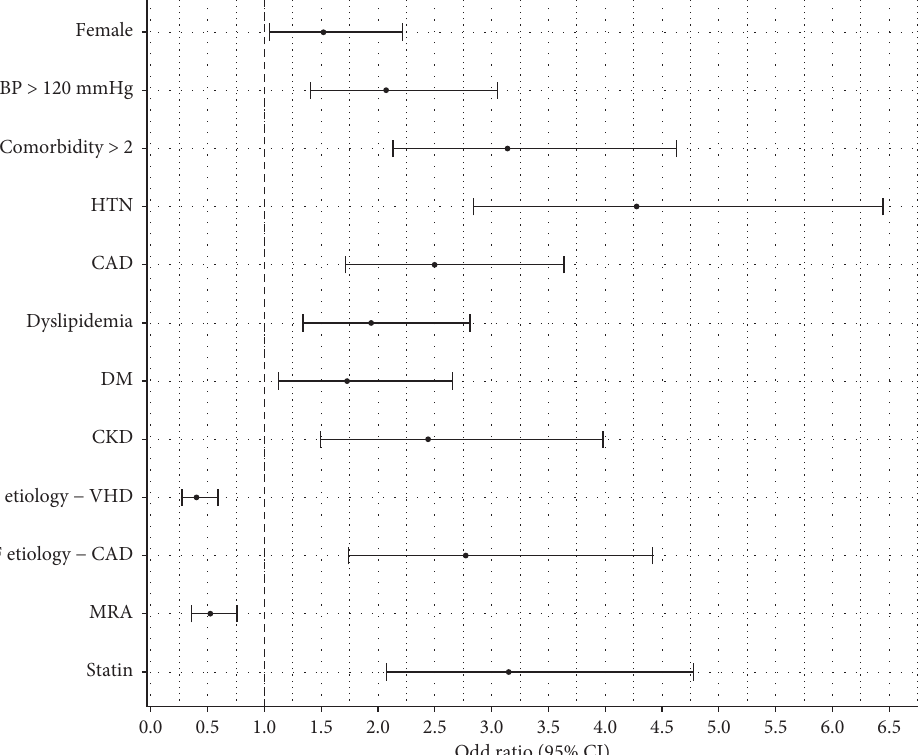
Table 2: Body mass index and comorbidity rates of our study compared with ASIAN-HF Registry, JASPER, TOPCAT, and I-PRESERVE trials.